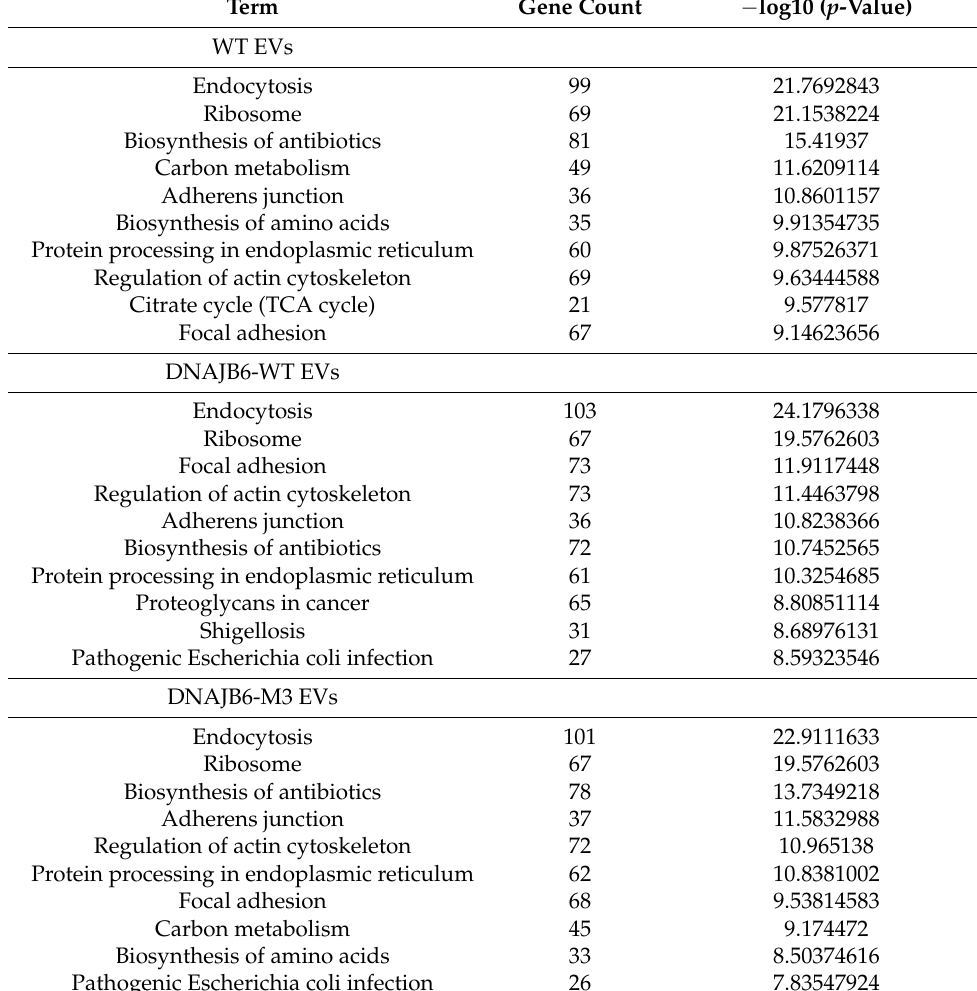
Table 2. Top 10 KEGG pathways for proteins in WT, DNAJB-WT, and DNAJB6-M3